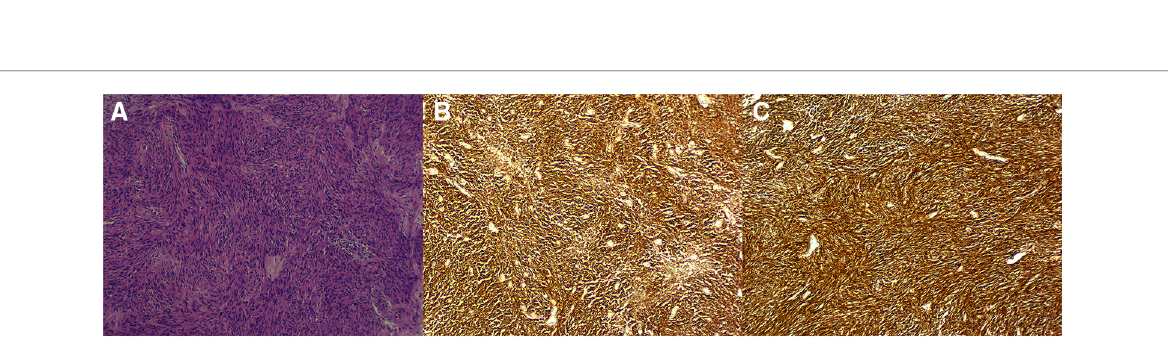
FIGURE 3 Hematoxylin and eosin staining showing a large number of spindle cells (10×10, A ). Immunohistochemical staining showing tumor cells positive for c-kit ( B ) and DOG-1 ( C ).